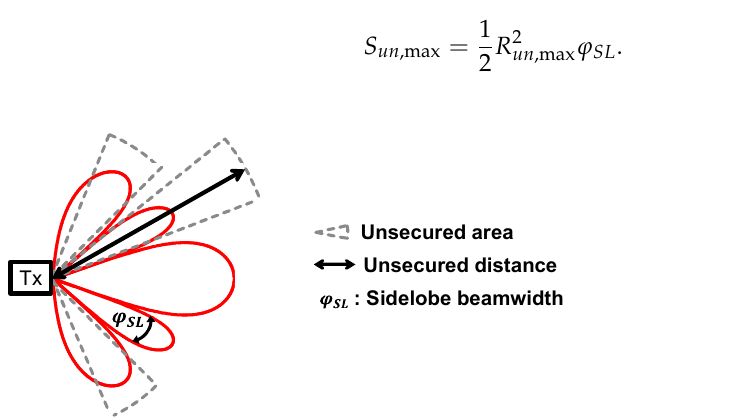
Figure 2. Conceptual diagram for calculating unsecured length and unsecured area factor.